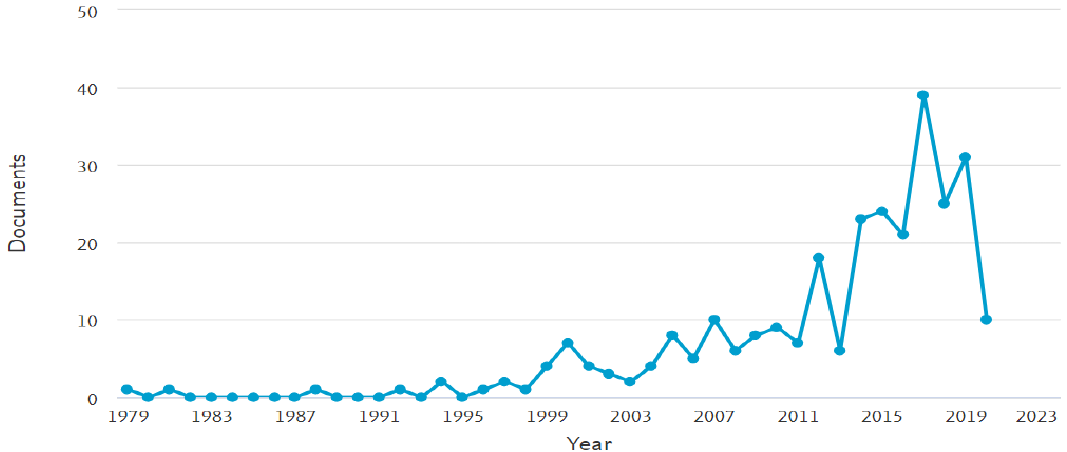
Figure 1. Number of articles published on fermented cereal-based products over the period 1979–2020, according to the Scopus database (last accessed 23/04/2020, document search: “fermented AND cereal AND based AND products”).